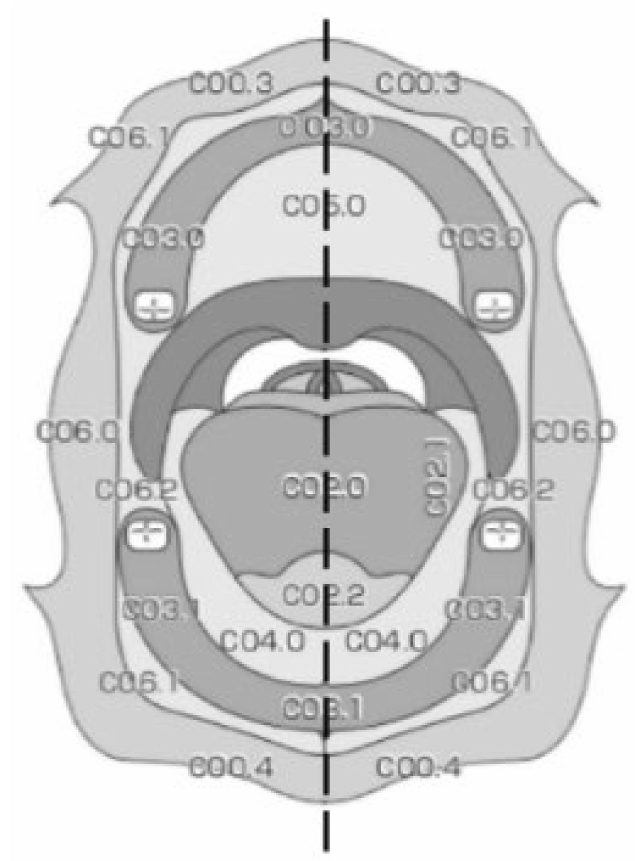
Figure 2. Anatomical sites and subsites of the oral cavity.